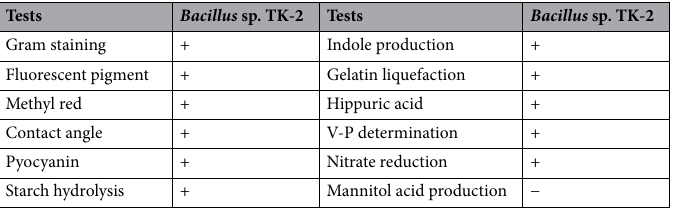
Table 1. Determination of physiological and biochemical characteristics of the strain TK-2.